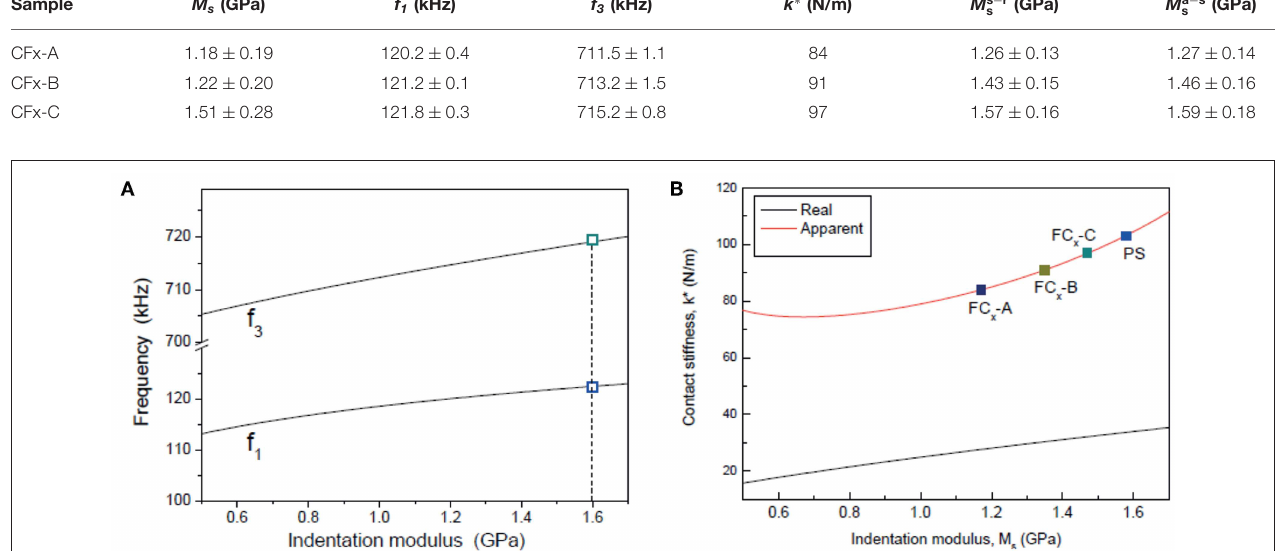
FIGURE 7 | (A) Values of the CRFs f 1 and f 3 calculated as a function of the sample indentation modulus M s using the model depicted in Figure 1A (solid lines) and values of f 1 and f 3 measured on the PS reference material (symbols). (B) Real and apparent contact stiffness (black and red solid line, respectively) as a function of the sample indentation modulus, and values corresponding to the CF x and PS samples (symbols).